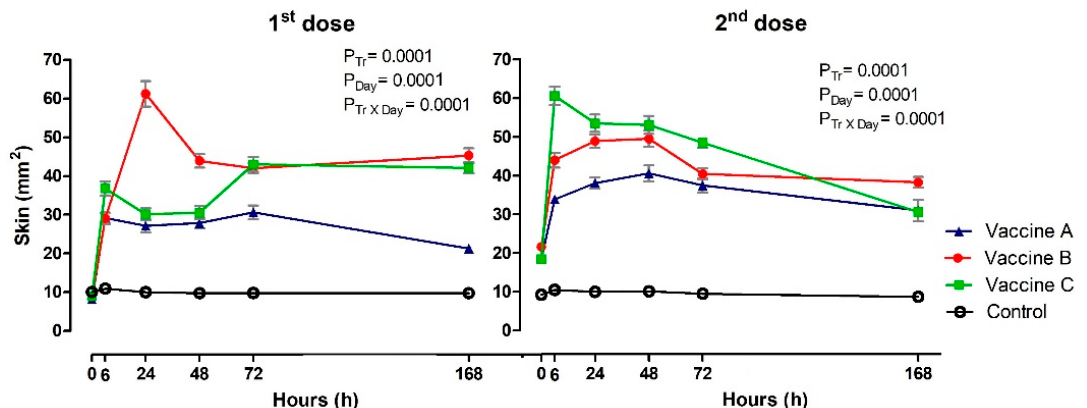
Figure 2. The figure represents the mean values and standard deviations of local vaccine reaction with skin thickness at the injection site in animals vaccinated with three different formulation adjuvanted vaccines against BVDV and BHV-1. Overall statistical significance ( p ≤ 0.05) is indicated in the plot as follows: Effects of treatment (P tr ), day (P Day ) and interactions (P tr x P Day ).